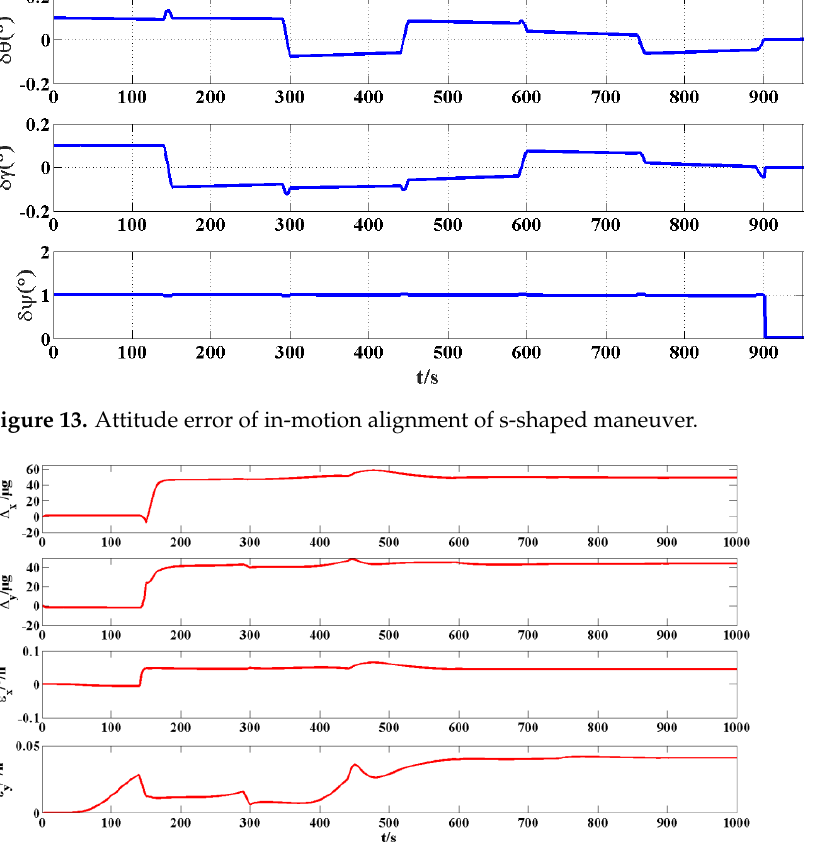
Figure 14. Estimation values of IMU constant error (s-shaped maneuver). The pitch error is 0.0003 , the roll error is 0.0011 and the heading error is 0.0039